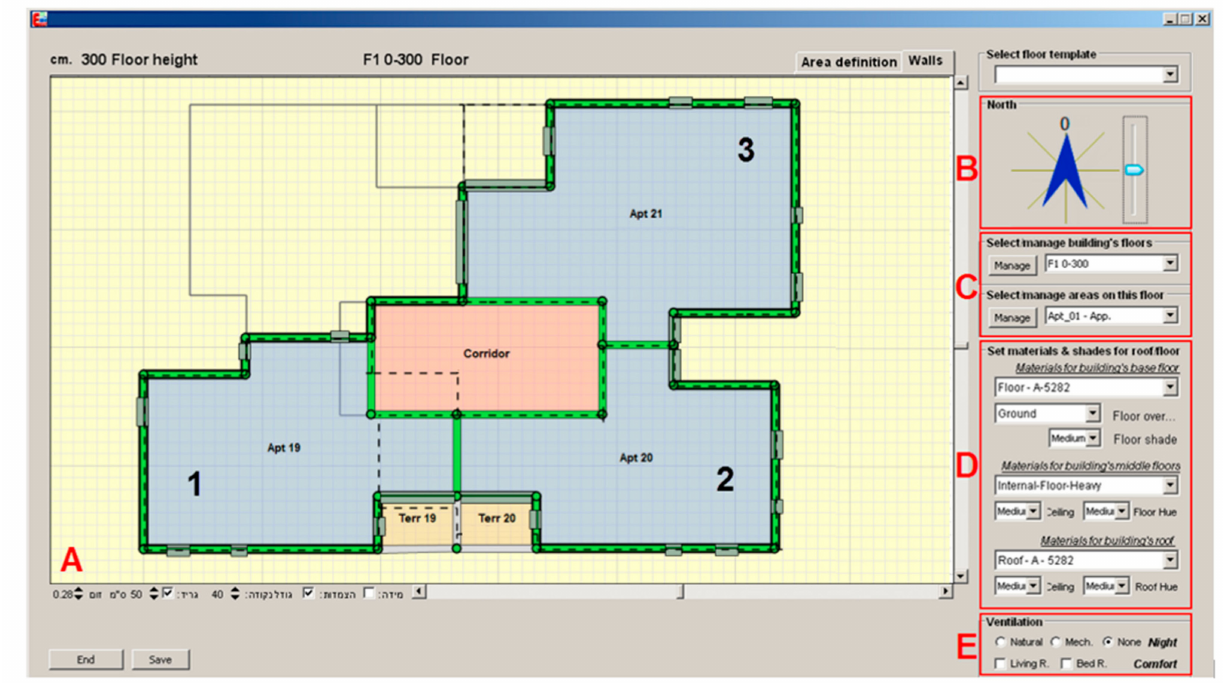
Figure 4. ENERGYui modeling